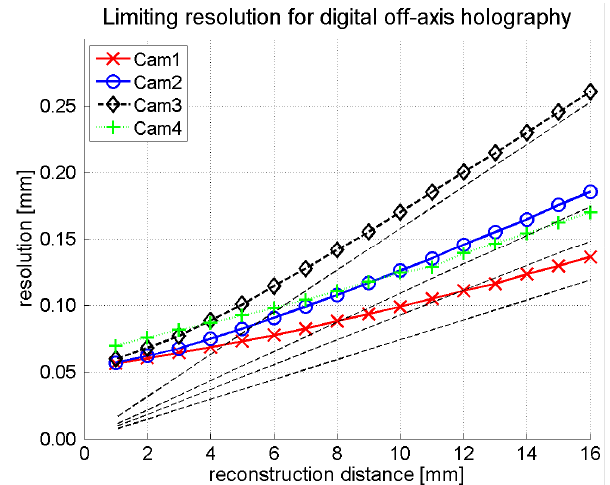
Figure 7. Fourier transform of the interference pattern recorded at λ = 118.8 μ m. ( a ) Cam1; ( b ) Cam2; ( c ) Cam3; ( d ) Cam4.